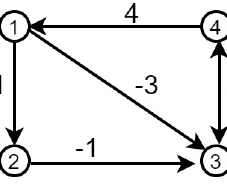
Figure 1. Topology